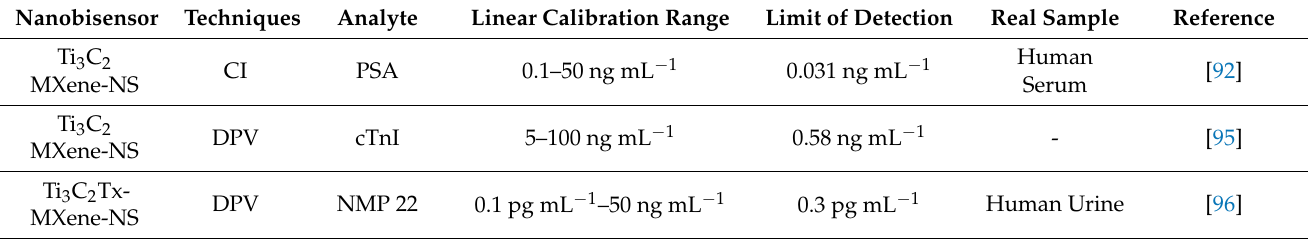
Table 4. Summary of discussed MXenes-based nanobiosensors with electroanalytical parameters.